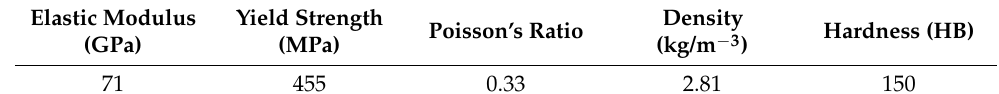
Table 2. Mechanical properties of 7075-T7401.